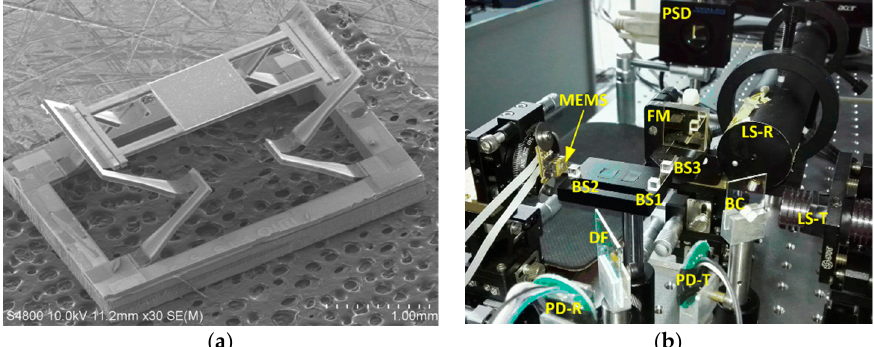
Figure 31. H-shaped LSF electrothermal MEMS based FTS: ( a ) A SEM of MEMS mirror; ( b ) a picture of FTS system. (Reprinted with permission from Reference [58] MDPI).